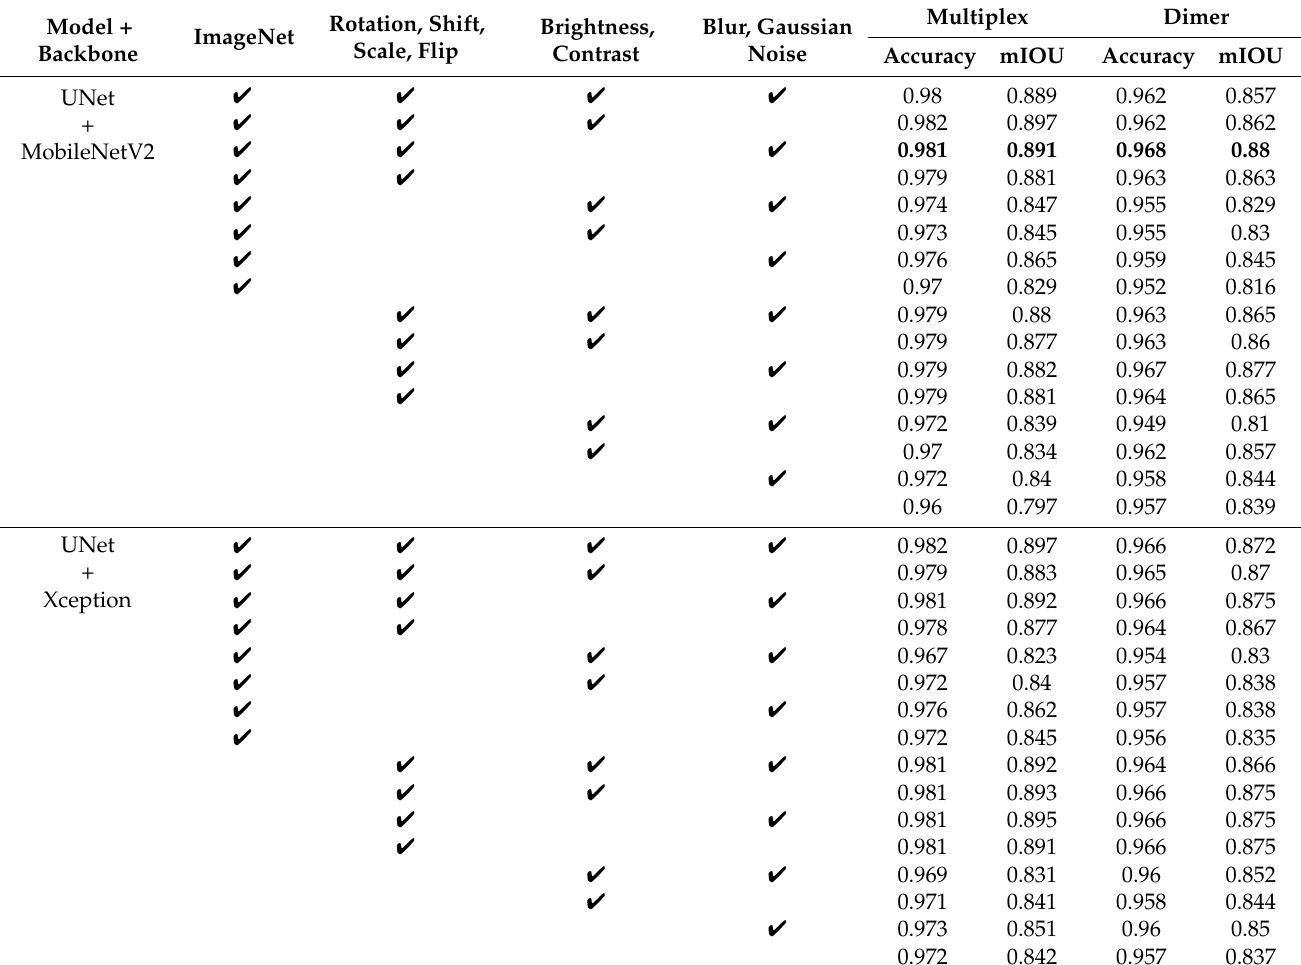
Table 3. Summary of fluorescence target segmentation results for UNet